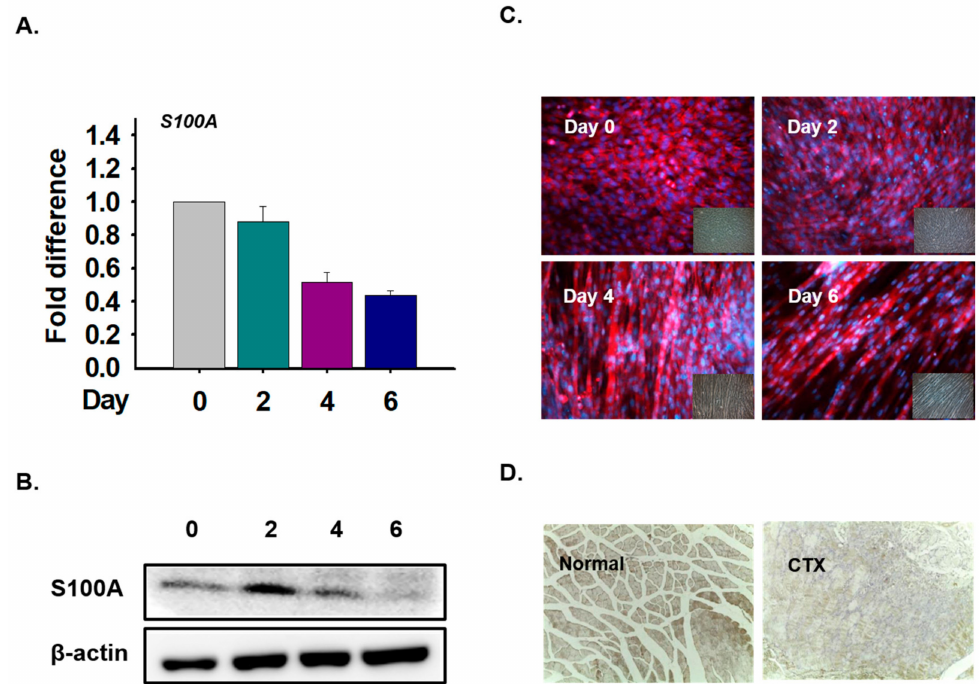
Figure 10. S100A1 expression in myoblast di ff erentiation and muscle regeneration. C2C12 cells were cultured with 2% FBS for 0, 2, 4, and 6 days. mRNA protein expression was analyzed using real-time RT-PCR, Western blot, and immunocytochemical techniques. ( A ) mRNA expression using real-time RT-PCR. ( B ) and ( C ) S100A1 protein expression using Western blot and immunocytochemical techniques. CTX was injected in the GAS muscle and maintained for 7 days. ( D ) S100A1 protein expression in normal and CTX-injected